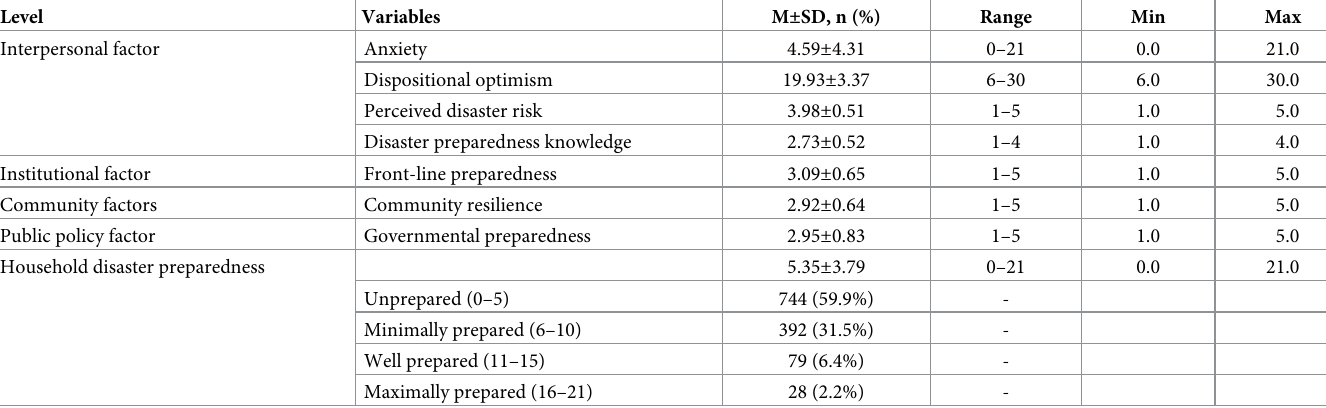
Table 2. Level of study variables ( N = 1,243).